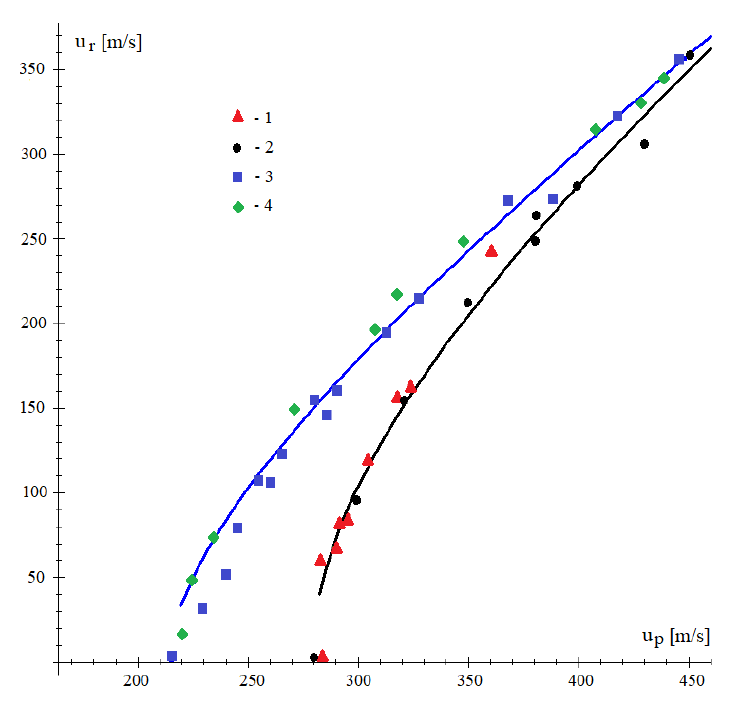
Fig. 5. Ballistic curves for the 2R configuration: two-layer steel barrier 2x6 mm with 24 mm spacing. Designations: 1 – experimental data from [1], 2 – results of 2D calculations with variable yield strength Y, 3 – results of 2D calculations with constant yield strength Y = 860 MPa, 4 – 3D calculation results, the curves are Lambert-Jonas functions approximating the